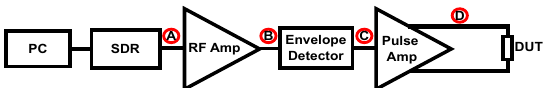
FIGURE 2. Block diagram of the